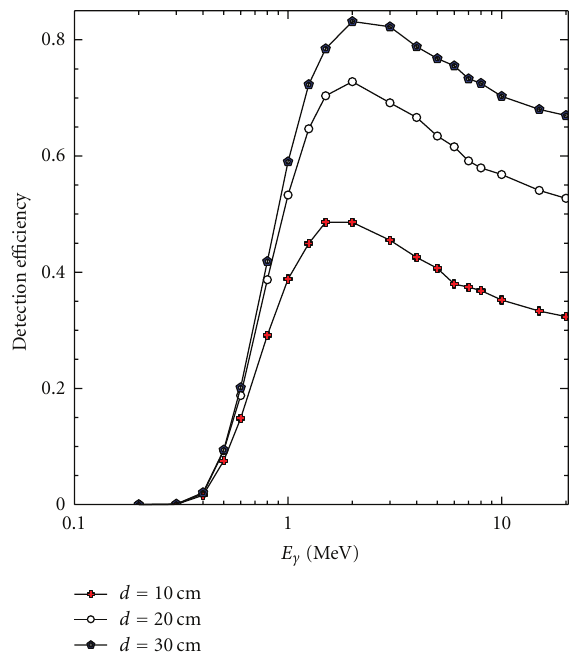
Figure 7: The detection e ffi ciency of CPID as a function of incident X-ray energy for various thicknesses.